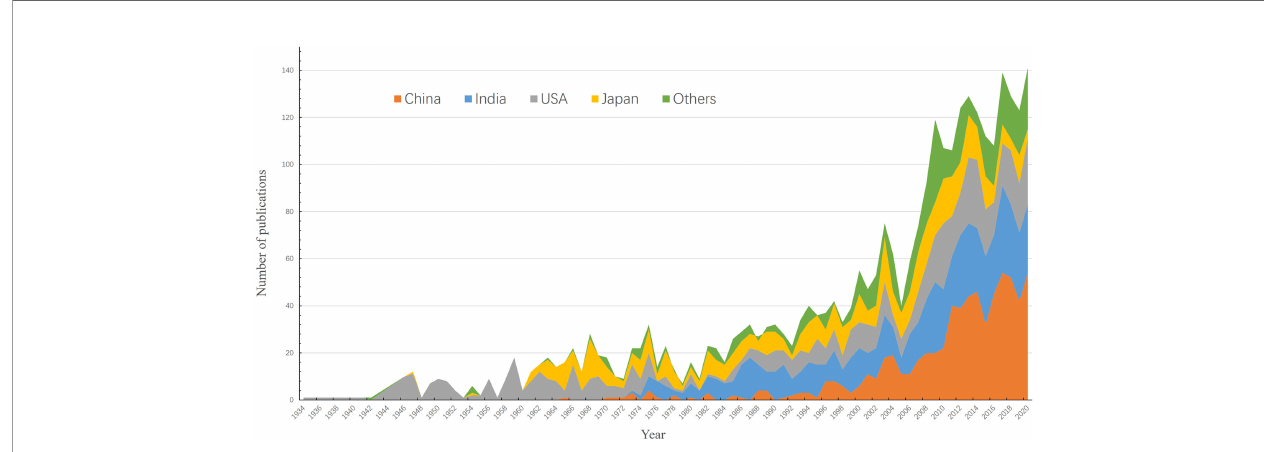
FIGURE 1 | Number of literatures published each year. The abscissa represents the publication year, the ordinate represents the publication amount, and the colors are used to code the publications from different